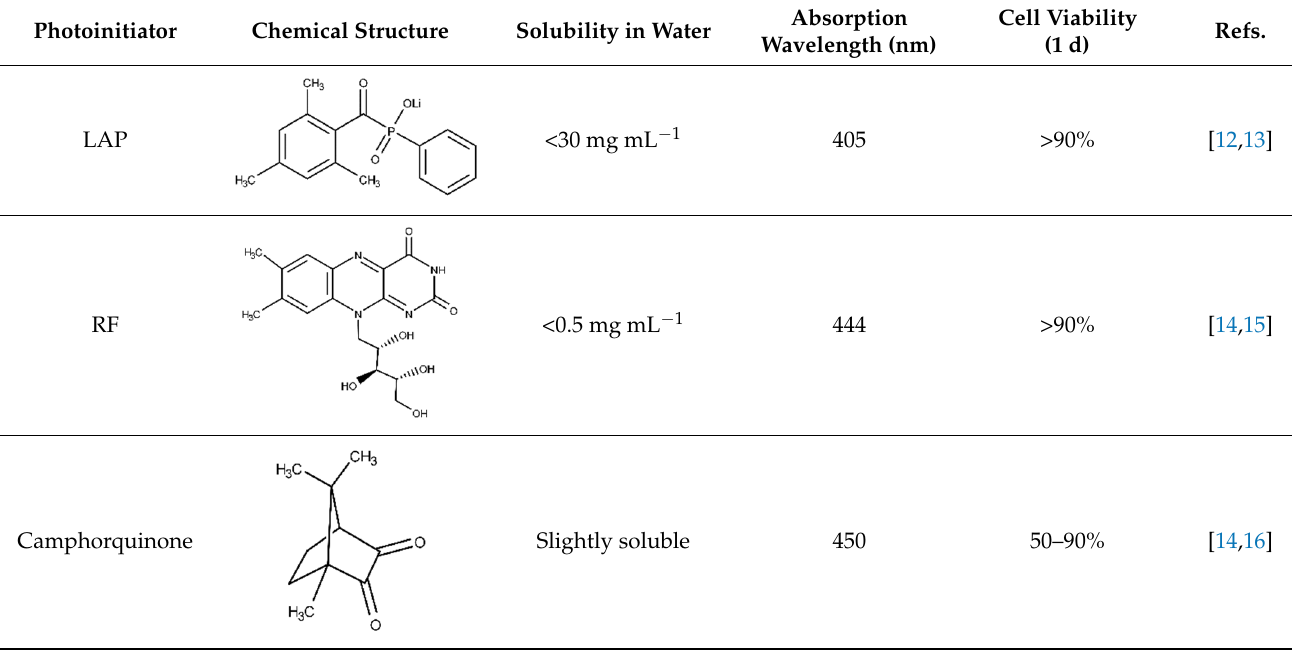
Table 1. Types of visible light-mediated photoinitiators. Adapted with permission from [11].